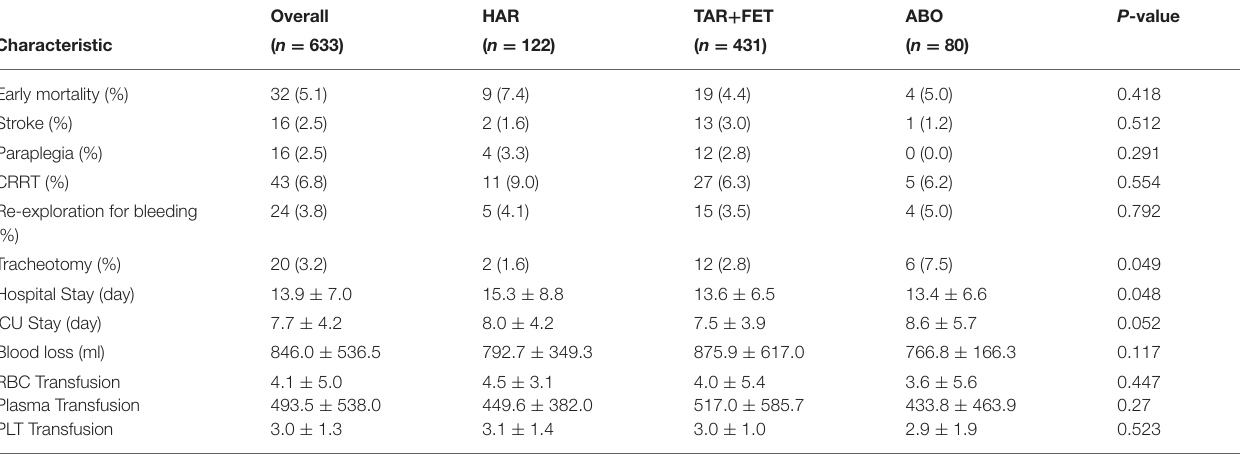
TABLE 5 | Early outcomes for the total cohort and each group before using the matching weight method. Overall HAR TAR + FET ABO P -value